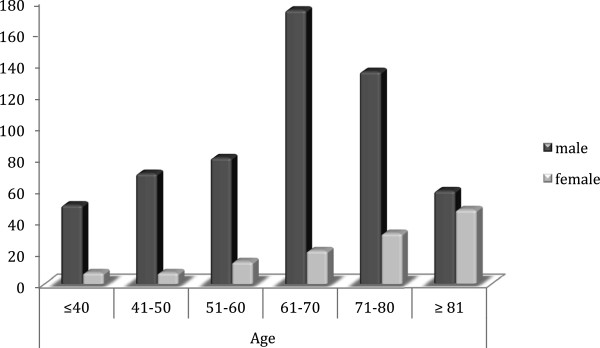
Bar graph of sex as a function of age for 778 patients with CSDH.